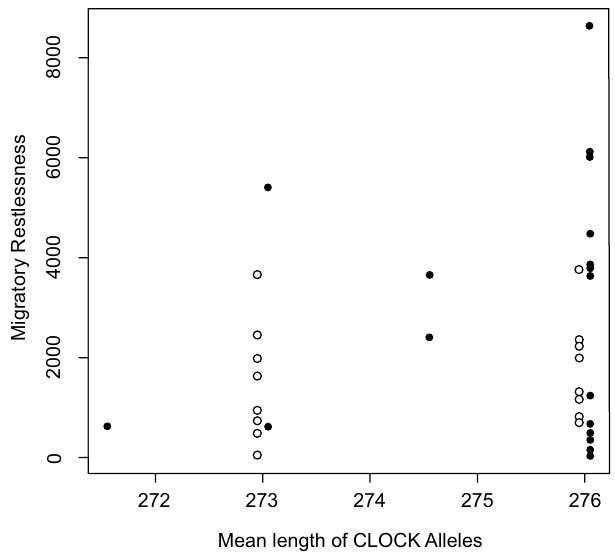
Figure 6. CLOCK and individual variation. Plot shows individual migratory restlessness score for Oregon juncos against the mean length of the CLOCK alleles from the migratory population at Laguna Mountain, CA, USA (solid circles) and the sedentary population in San Diego, CA, USA (open circles). Points are slightly jittered for each population to improve visualization. There is no significant relationship between CLOCK length and migratory